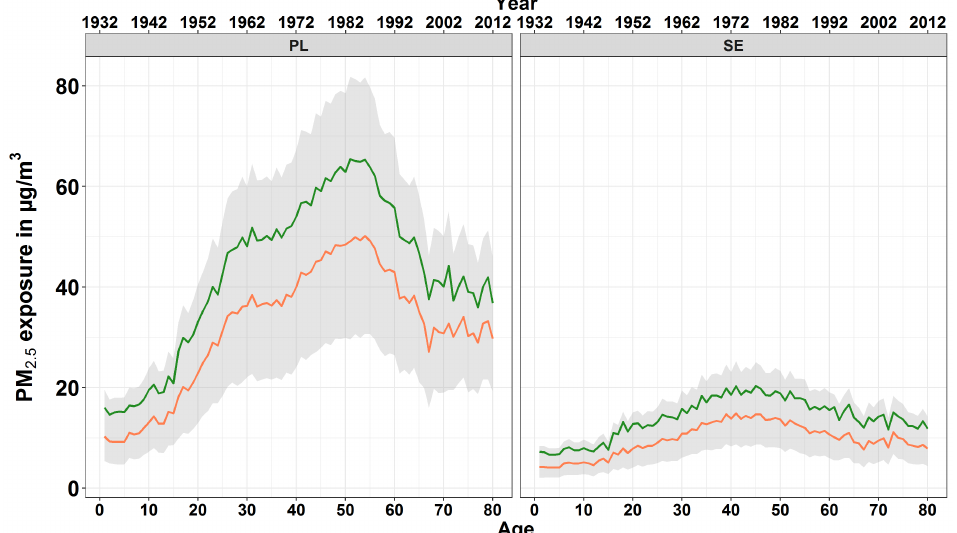
Figure 10. Temporal course of the lifelong exposure to PM 2.5 for an 80-year-old male from Poland and Sweden. The green line, red line and grey ribbon represent the mean, median and range of 25th to 75th percentile of the exposure level.